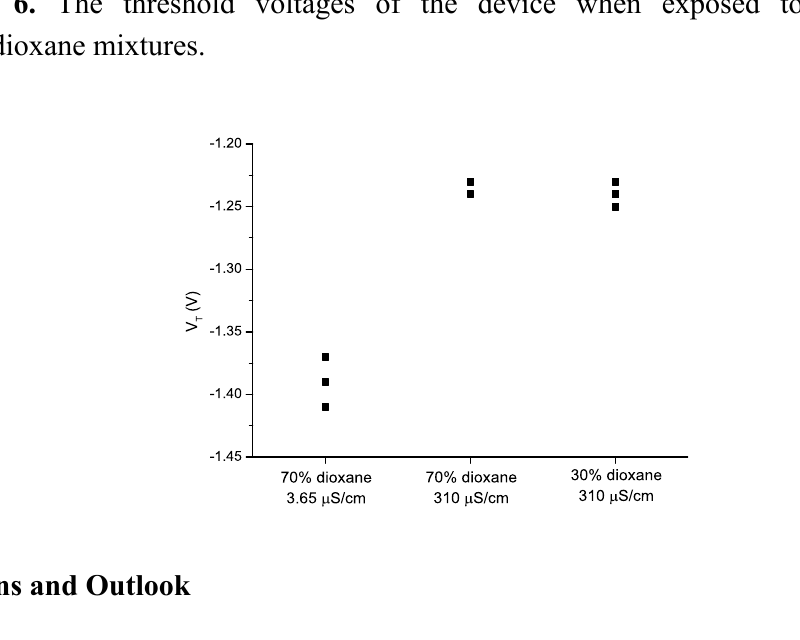
Figure 6. The threshold voltages of the device when exposed to three different water − dioxane